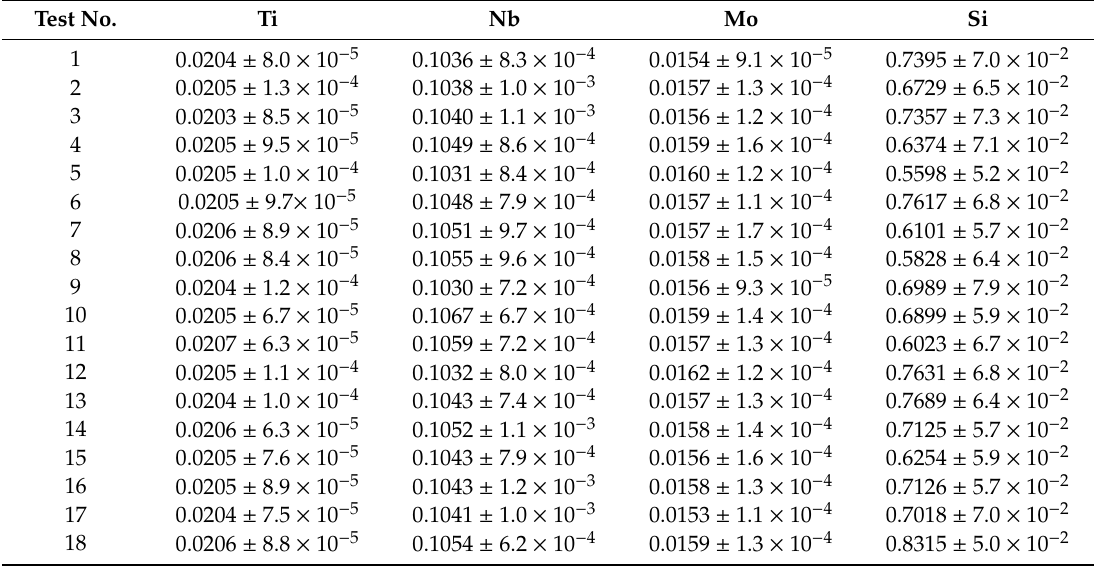
Figure 7. Result of SEM image for upper area in weldment. Table 7. Results of chemical properties for fiber laser welding.